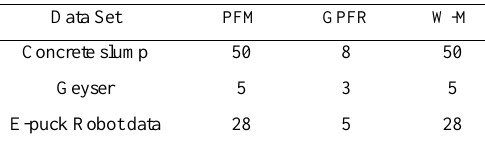
Table 3 . Number of fuzzy rule.